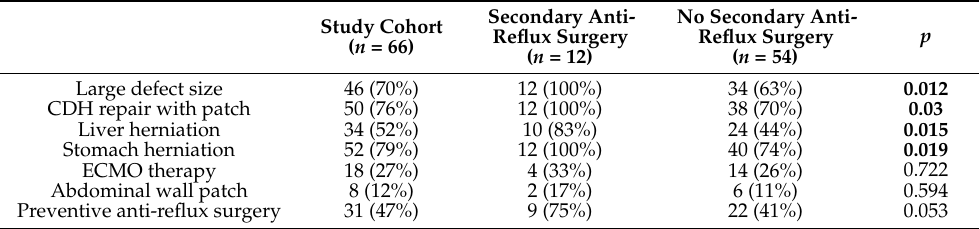
Table 3. Surgical characteristics of patients with and without secondary anti-reflux surgery. Study Cohort ( n =